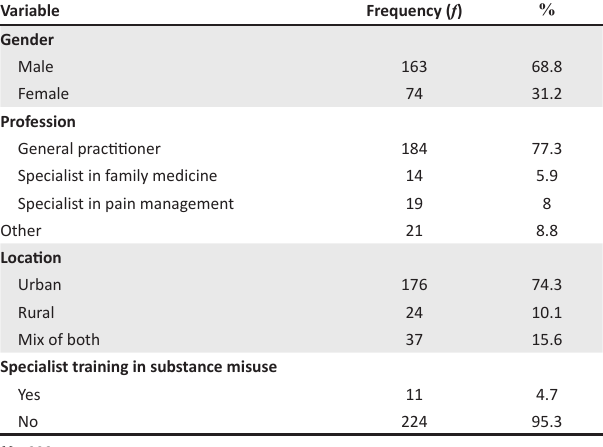
TABLE 1: Demographic information of study respondents.